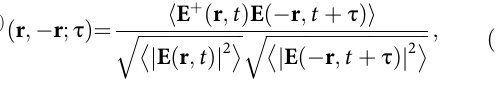
V = ( I max − I min )/( I max + I min ) as a measure for the correlation function, where I max ( I min ) denote maximum (minimum) intensities of the fringe pattern around the path difference Δ ℓ .